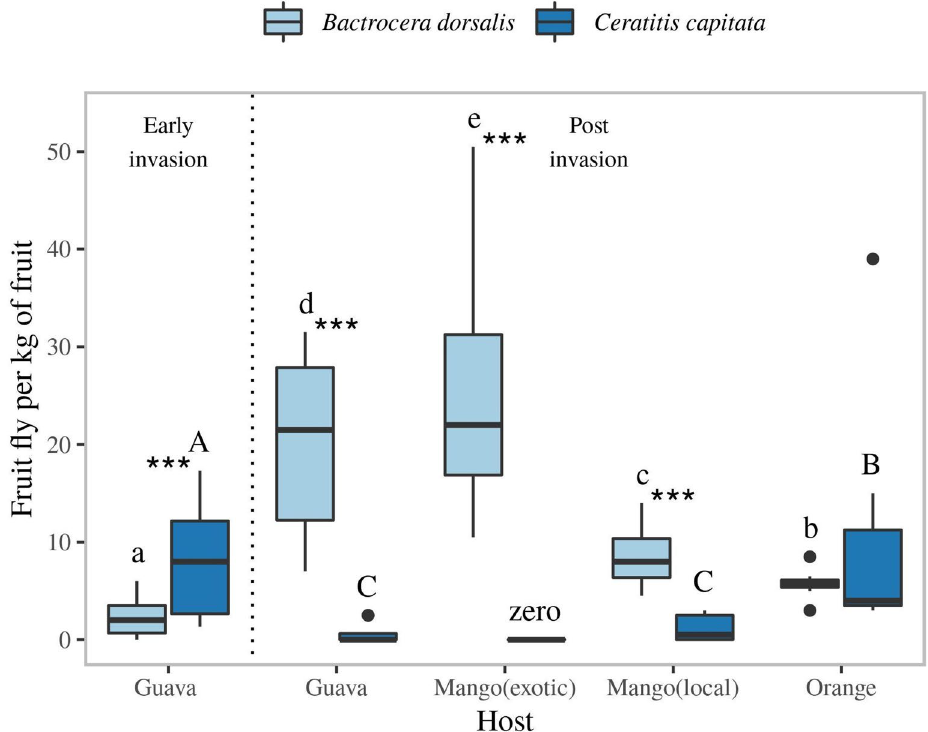
Figure 6. Number of adult C. capitata and B. dorsalis emerging from guava, mango (two cultivars), and orange collected in Arba-Minch. The left part of the graph shows emergence from fruits prior to B. dorsalis invasion (only in guava), whereas right part of the graph shows emergence after invasion of B. dorsalis . Tukey’s boxplots indicate the median, the 25 and 75 percentile boundaries (box), and 1.5 times the interquartile (IQ) range (whiskers). Dots represent outliers outside the 1.5 IQ range. Different letters/letter cases indicate a difference in fruit fly emergence per kg of fruit per host, with capital letters representing C. capitata and small letters representing B. dorsalis . Statistics were performed using a general linear model with a poisson distribution, n = 8, *** represents differences between species at p ≤